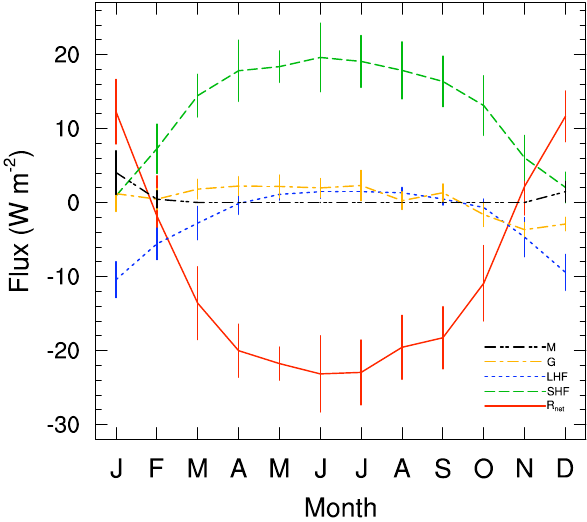
Fig. 5. Monthly mean energy balance components and their inter- annual variability (1993–2007) from the surface energy balance model, driven by observation, which is described by Van den Broeke et al. (2006). The error bars indicate two standard devia- tions from the mean. Shown are the balance of shortwave and long- wave fluxes ( R net ), latent heat flux (LHF), sensible heat flux (SHF), ground heat flux (G) and melt